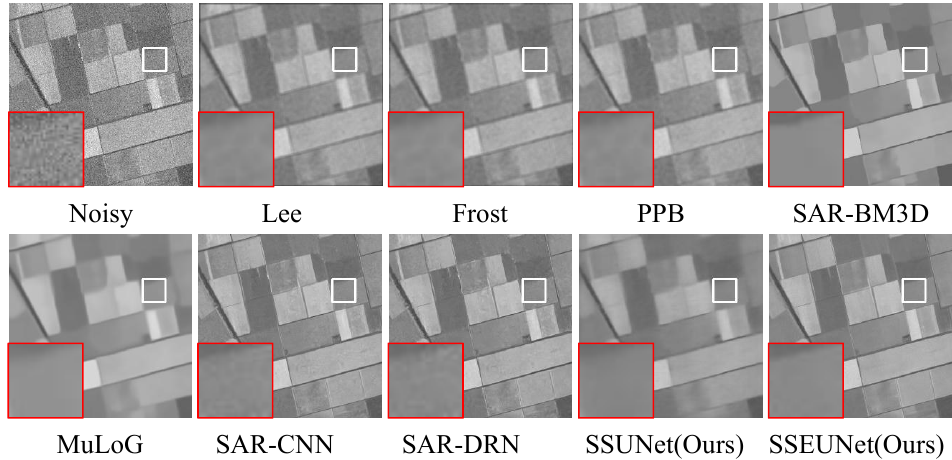
Figure 11. Visual results of homogeneous regions on real-word SAR